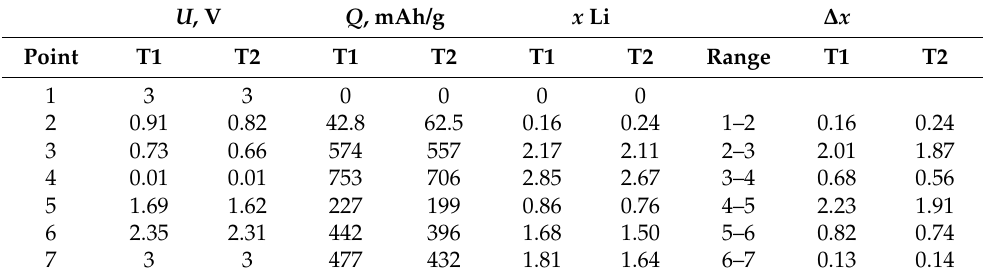
Table 1. Coordinates of characteristic points on charge and discharge curves of cycle 1 (Figure 1a), their corresponding amount of embedded or extracted lithium x , and its increment Δ x at each step.